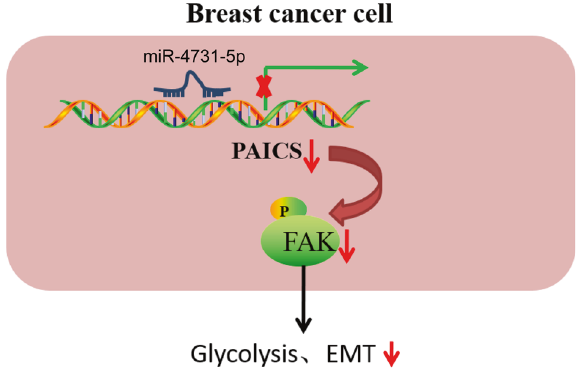
Fig. 8 Schematic map of the underlying mechanism concerning the role of miR-4731-5p in breast cancer. miR-4731-5p inhibited the glycolysis and EMT of breast cancer cells via downregulation of p-FAK through reducing PAICS